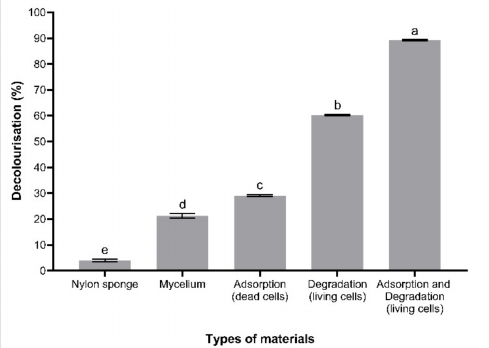
Figure 5. Adsorption capacity of nylon sponge, fungal mycelium, dead cells of immobilised T. hirsuta PW17-41 and living cells of immobilised T. hirsuta PW17-41 for textile dye decolourisation under optimal conditions at 4% ( v/v ) initial dye concentration for 2 days at 100 rpm and 30 ◦ C. Error bars indicate standard deviation and letters a–e indicate statistically significant differences between groups analysed via one-way ANOVA ( n = 3, p <